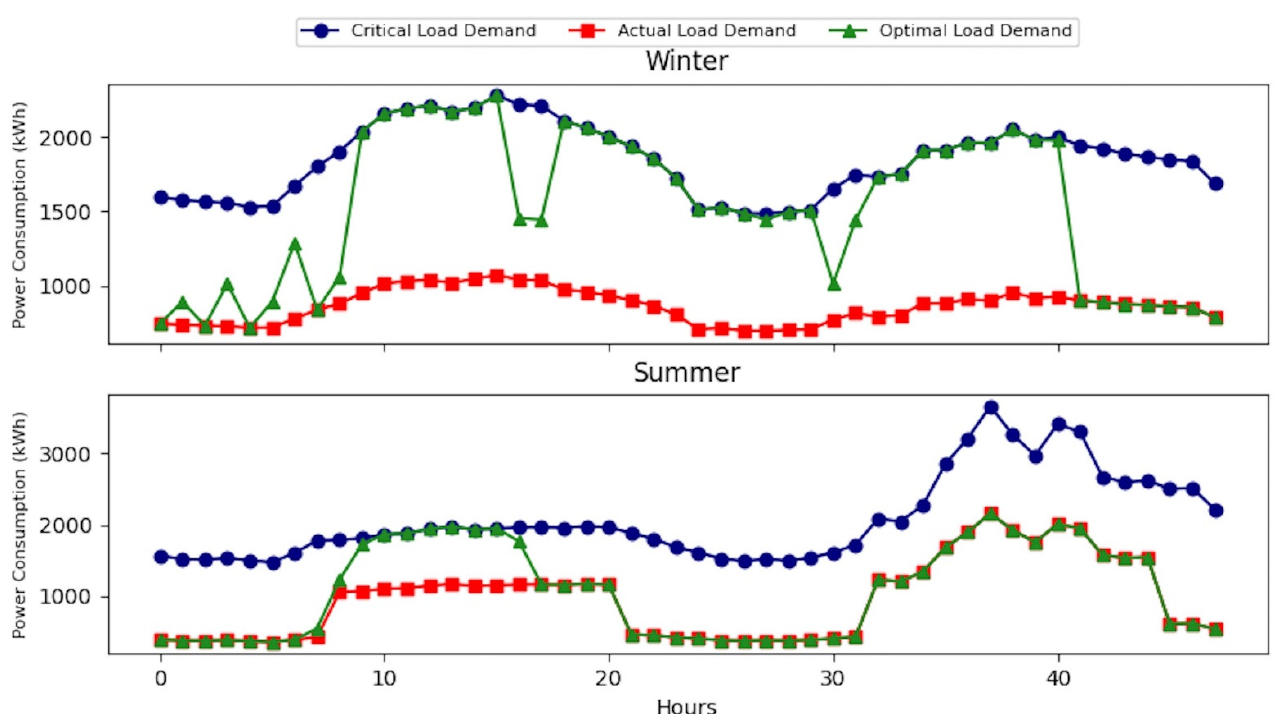
Figure 6. Optimal, actual, and critical loads for summer and winter.